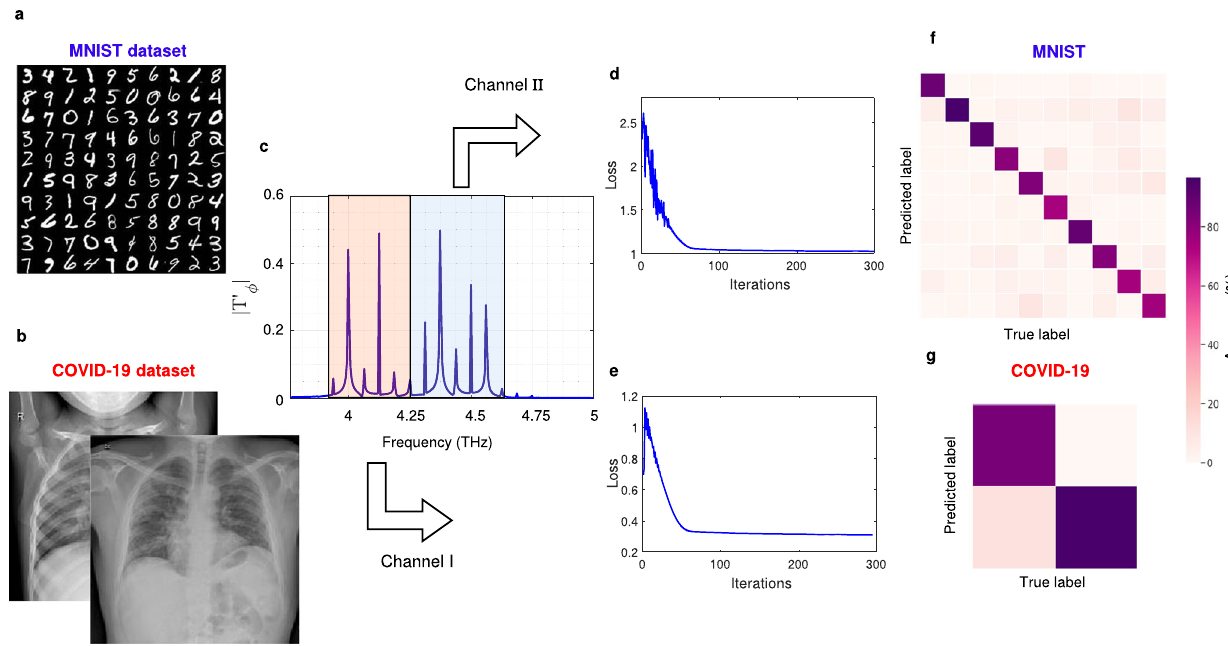
Fig. 6 Floquet extreme learning for parallel image classi fi cation. a, b Examples of realizations taken from the MNIST and COVID-19 X-ray datasets. c Simulated spectra of readout nodes for two different channels. d, e Evolution of the loss function for MNIST and COVID-19 classi fi cations, respectively. f, g Corresponding confusion matrices, for condition classi fi